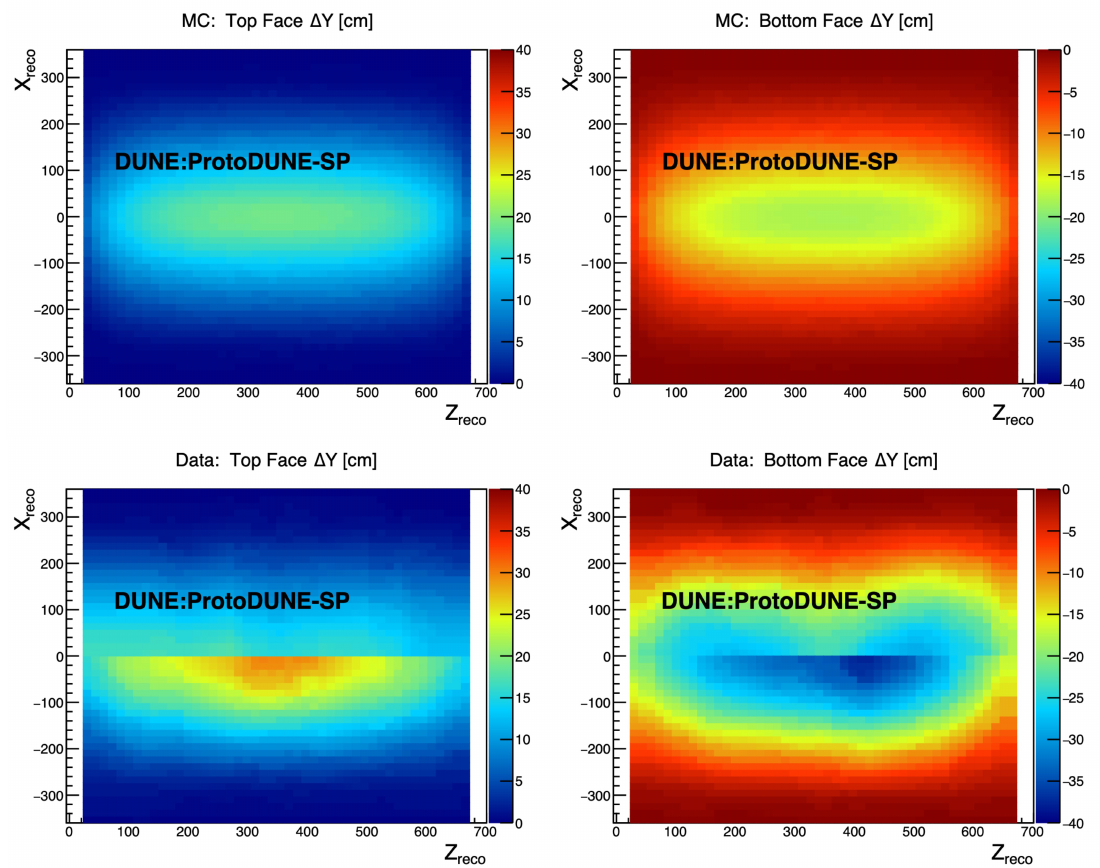
Figure 6. Predicted and observed transverse distortion on the top and bottom side faces, in the ProtoDUNE Single-Phase detector. The top panels show the distortion as predicted by an approximate numerical model. The amplitude of the distortion is maximal near the cathode ( x = 0), where it reaches about 20 cm, and vanishes on the boundaries with the anodes ( x = ± 360 cm) and with the other side faces. The distortion in the bottom panels is qualitatively comparable, but reaches larger values and shows large asymmetries between the top and bottom faces, and between the two sides of the cathode surface. Reproduced from reference